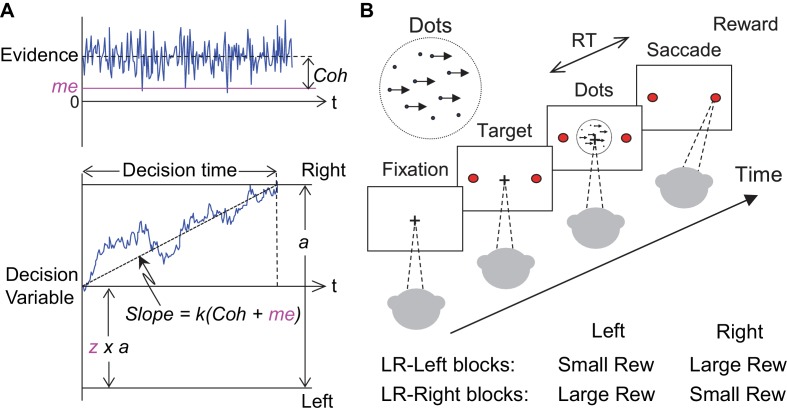
Theoretical framework and task design.(A) Schematics of the drift-diffusion model (DDM). Motion evidence is modeled as samples from a unit-variance Gaussian distribution (mean: signed coherence, Coh). Effective evidence is modeled as the sum of motion evidence and an internal momentary-evidence bias (me). The decision variable starts at value a × z, where z governs decision-rule bias and accumulates effective evidence over time with a proportional scaling factor (k). A decision is made when the decision variable reaches either bound. Response time (RT) is assumed to be the sum of the decision time and a saccade-specific non-decision time. (B) Response-time (RT) random-dot visual motion direction discrimination task with asymmetric rewards. A monkey makes a saccade decision based on the perceived global motion of a random-dot kinematogram. Reward is delivered on correct trials and with a magnitude that depends on reward context. Two reward contexts (LR-Left and LR-Right) were alternated in blocks of trials with signaled block changes. Motion directions and strengths were randomly interleaved within blocks.